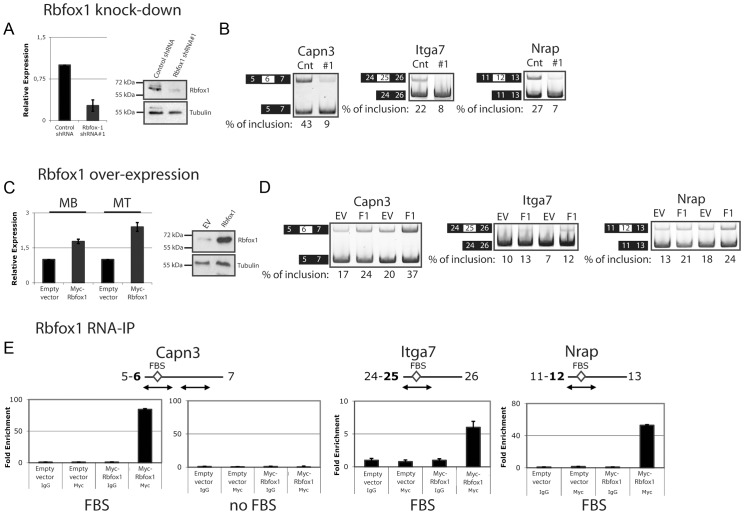

Rbfox1 down-regulation is responsible for significant portion of the splicing alterations in FRG1 mice.(a) Specific Rbfox1 knockdown was confirmed by real-time RT-PCR and immunoblotting using RNAs and proteins isolated from C2C12 muscle cells expressing a control non-silencing shRNA or an shRNA specific for Rbfox1 (shRNA#1). (b) Examples of alternative splicing changes caused by Rbfox1 knockdown are showed. Numbers are the percentage of exon inclusion. Black boxes illustrate constitutive exons, white boxes alternatively spliced exons. (c) Rbfox1 overexpression causes alternative splicing changes opposite to FRG1 over-expression. Specific Rbfox1 over-expression was confirmed by real-time RT-PCR and immunoblotting using RNAs and proteins isolated from C2C12 muscle cells expressing an empty vector (EV) or a Myc-tagged Rbfox1 (F1) either in proliferating or differentiating C2C12 muscle cells. (d) Examples of alternative splicing changes caused by Rbfox1 over-expression are showed. Black boxes illustrate constitutive exons, white boxes alternatively spliced exons. (e) Selective in vivo association of Rbfox1 to target regions displaying putative Fox binding sites (FBS). RIP experiment on samples from (c) using anti-Myc or control IgG antibodies. Immunoprecipitated material was analyzed by RT-PCR, quantified using the Typhoon, normalized versus the relative input and plotted as fold enrichment versus the IgG. RT-minus control experiments showed the absence of DNA contamination (data not shown).